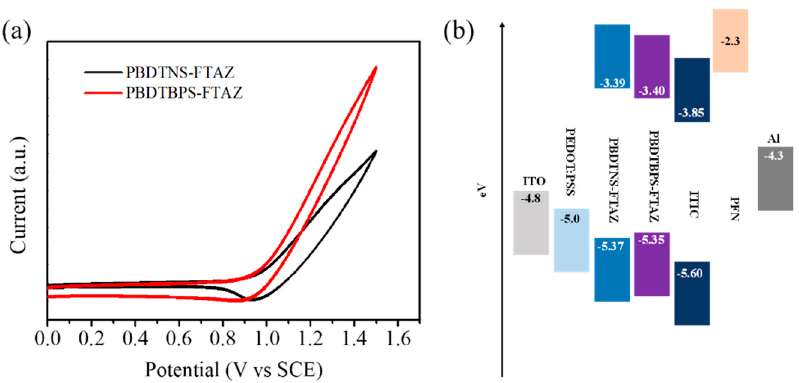
Figure 2. ( a ) Electrochemical cyclic voltammograms of the two polymers, ( b ) the band structure of the device.